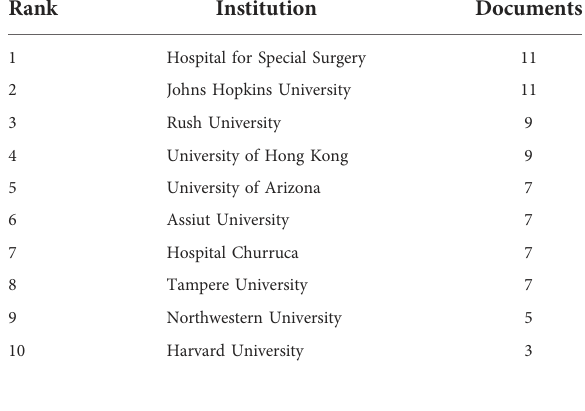
TABLE 1 Top 10 list of number of articles by